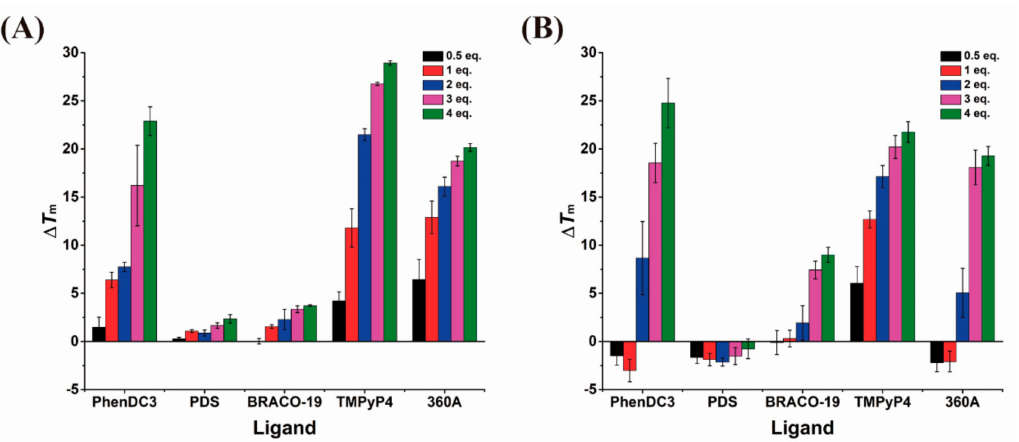
Figure 8. Comparison between thermal stabilization of ( A ) AS1411-N6 and ( B ) AS1411 induced by ligands obtained by FRET-melting experiments. The commercial ligands belong to distinct chemical families as acridines (BRACO-19), pyridines (PDS and 360A); phenanthrolines (PhenDC3), and porphyrin (TMPyP4).